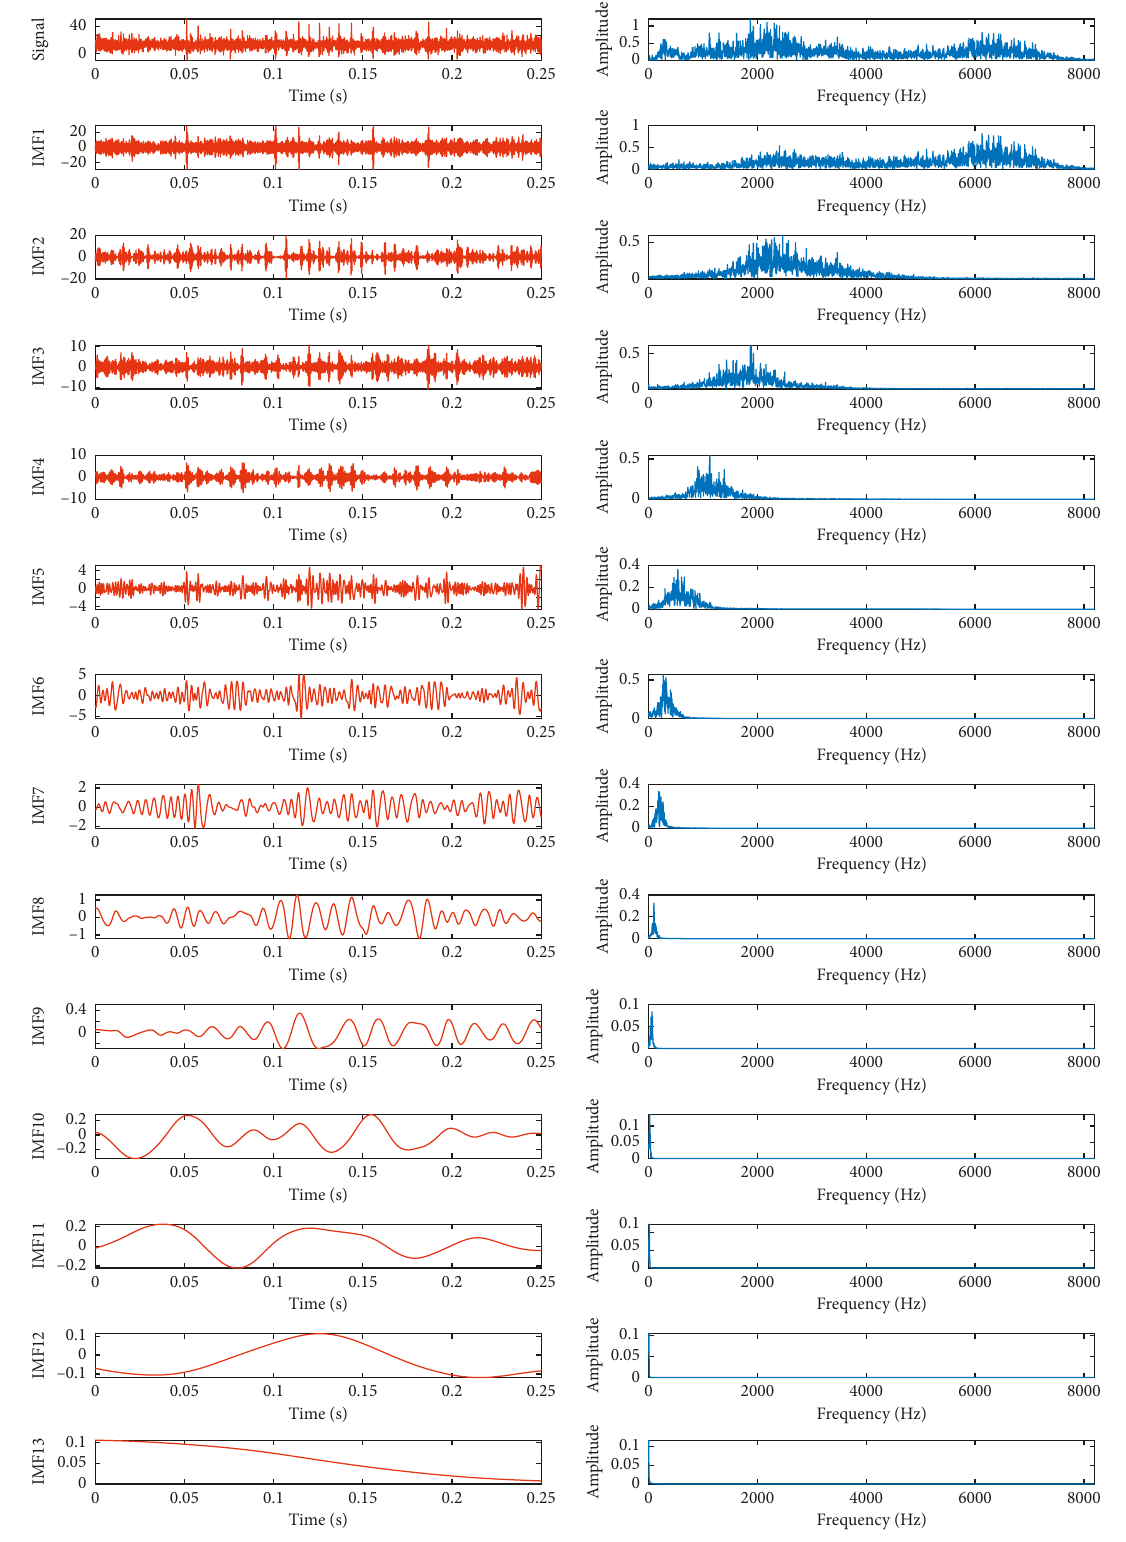
Figure 6: CEEMDAN